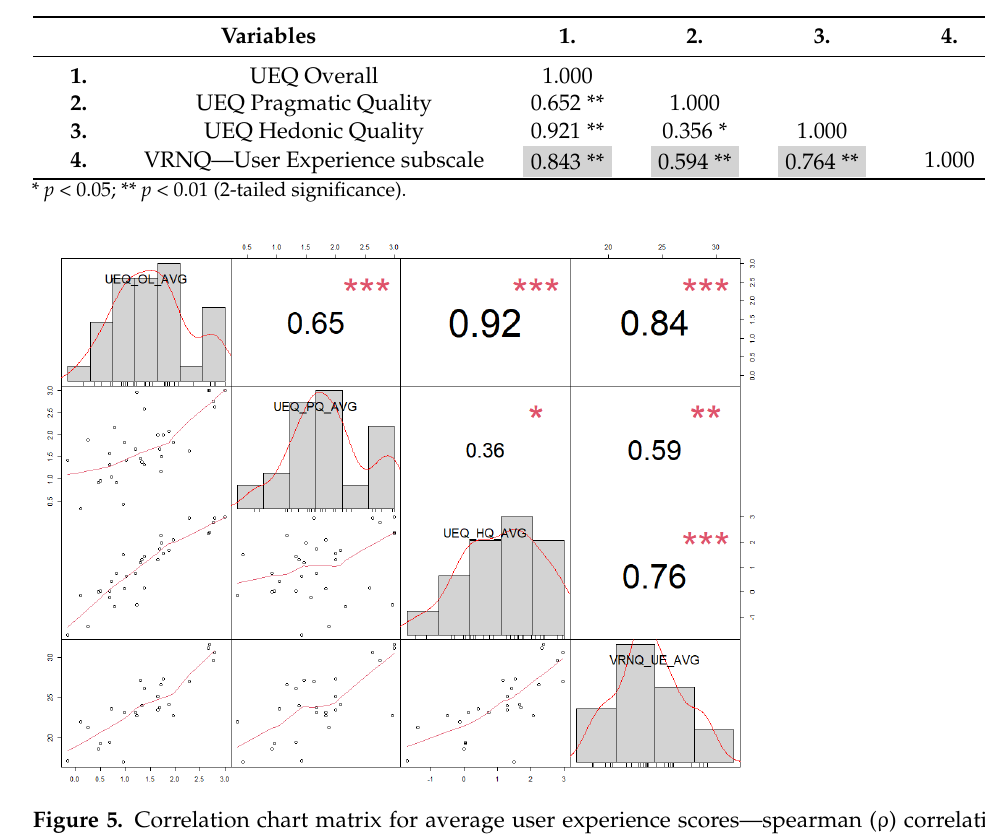
coefficients for combined user experience measures ( n = 4). There are also bivariate scatterplots on user experience measures ( n = 4). There are also bivariate scatterplots on the matrix, with a fitted line and a histogram for